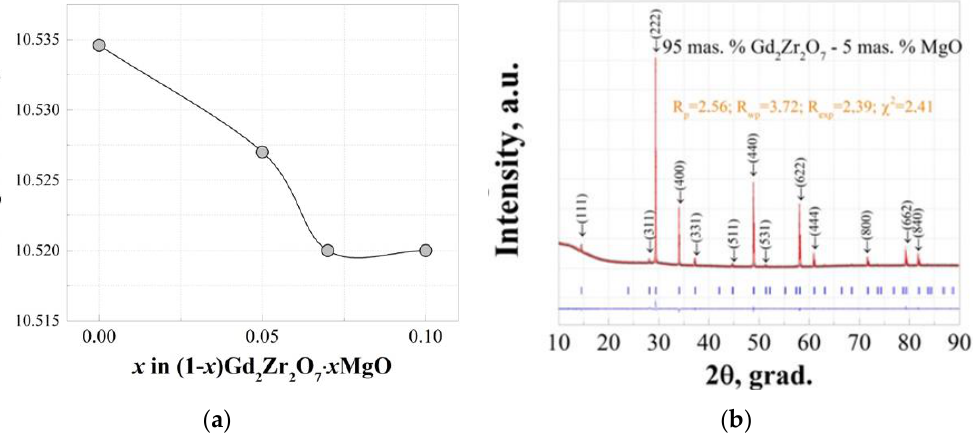
Figure 2. ( a ) Graph of the dependence of the lattice parameter on the composition. ( b ) X-ray diffraction pattern of the 0.95Gd 2 Zr 2 O 7 –0.05MgO sample processed using the FullProf program. Table 1. The refined coordinates of atoms of 0.95Gd 2 Zr 2 O 7 –0.05MgO in a cubic unit cell (space group Fd-3m) in the Gd and Zr disorder